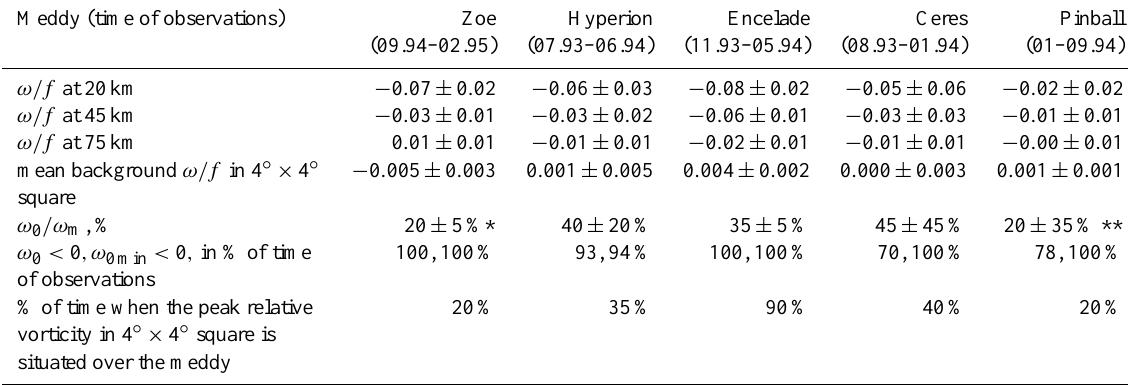
Table 2. Mean vorticity values (normalized by f ) at various distances from the centres of meddies, as calculated from RAFOS floats; ω 0 and ω 0min , are the average and the peak negative vorticity over the 100km around the meddy centre. Meddy (time of observations) Zoe Hyperion